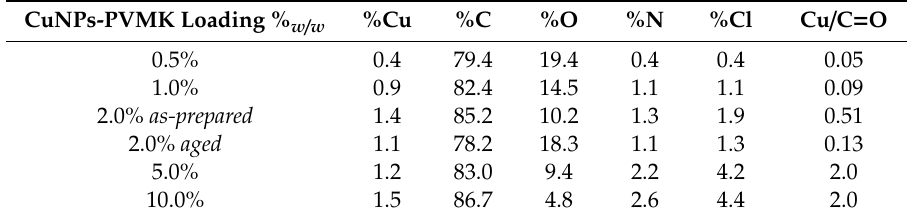
Table 2. XPS surface elemental composition of the nanocomposite films at di ff erent copper loadings. The error in the atomic percentages is 0.2% for copper, 0.5% for all the other elements.